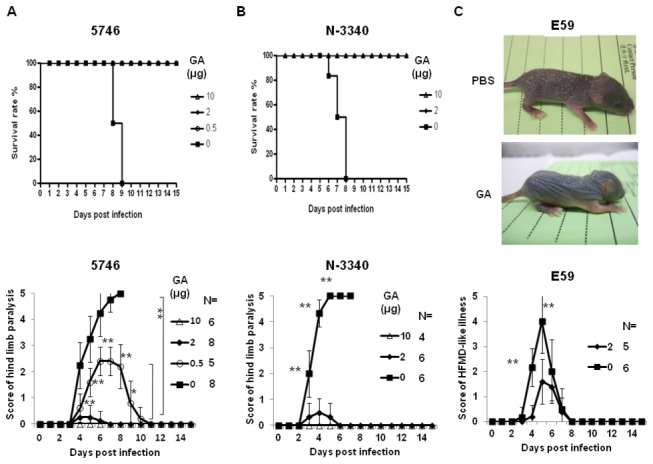
17-AAG confers protection against the different genotypes of EV71 in hSCARB2-transgenic mice.Seven-day old mice subcutaneously preinfected with 3x106 pfu of (A) EV71 5746 (C2) or (B) N-3340 (C4), or (C) one-day old mice preinfected with 1x107 pfu of EV71 E59 (B4), were given various dose of 17-AAG intraperitoneally twice at the time points of 4 hours and 24 hours after infection. The same age of infected mice treated with the same volume of vehicle (10% DMSO plus 5% glucose) as control were included. Mice were monitored daily and the survival rates and the score of HLP were recorded in (A) (B), and the score of HLS was recorded in (C). The criterion to score the severity of HLP and HLS was described in the Materials and Methods. The mean of score from each group was calculated and the number of mice (N) in each group was shown. 100x magnification of pictures (C) shown the representative data were taken on day 5 post infection. The Logrank test for survival rate and One-way ANOVA with the Kruskal-Wallis test for the score of HLP and HLS were calculated for statistical analysis.